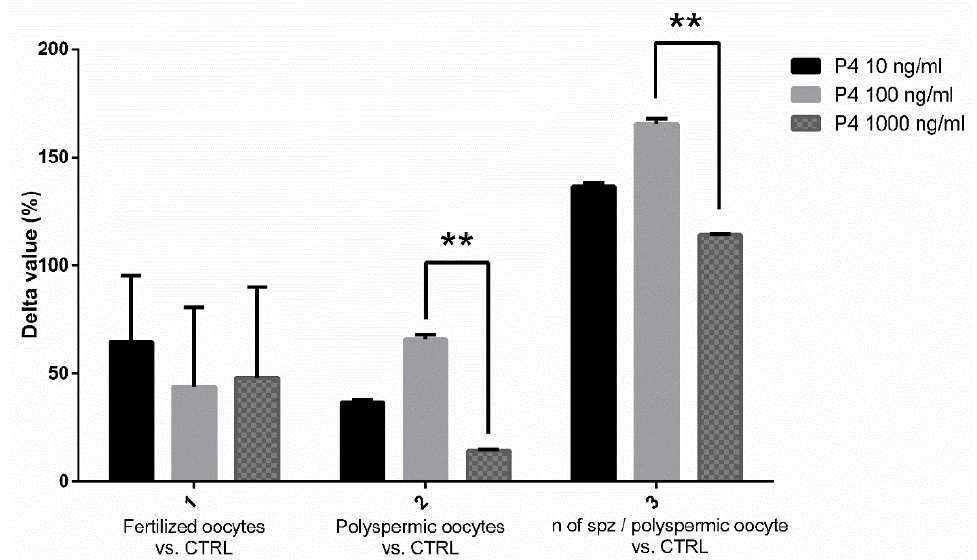
Figure 4. Graphical representation of the effects of P4 at different concentrations. Results are expressed as the difference in percentage ( ∆ IVF%) of the fertilization rates, the number of polyspermic oocytes and the number of spermatozoa per polyspermic oocyte, comparing the groups of spermatozoa capacitated in the presence of SOEC treated with P4 (at 10, 100 and 1000 ng/mL) to the control group without P4. The best IVF results were obtained when SOECs were treated with P4 at 100 ng/mL, due to the higher values obtained with this concentration in terms of difference of percentage in the number of polyspermic oocytes and in the number of spermatozoa/polyspermic oocyte. The data are presented as mean of four independent experiments. Data were analyzed using a Tukey’s test ** p < 0.01.